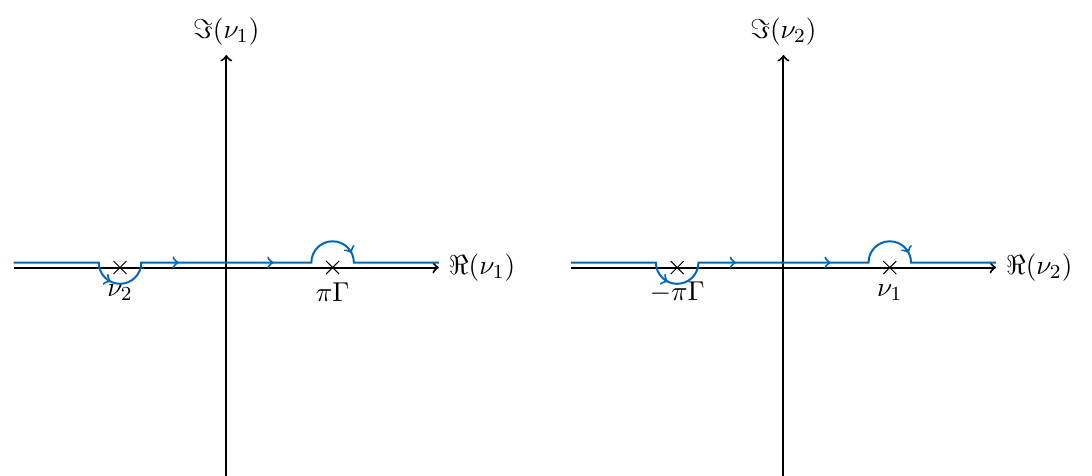
Figure 3 . Integration contour for the seven-gluon BFKL